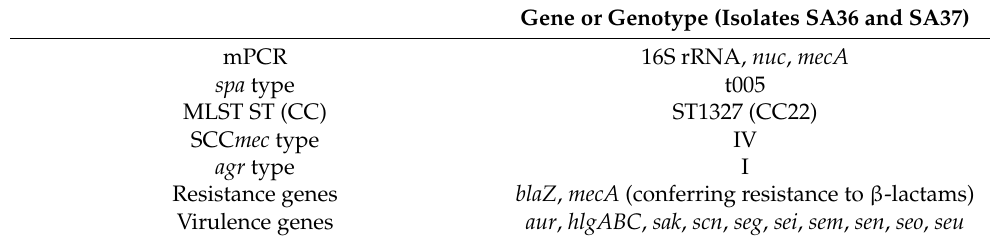
Table 2. Genetic characteristics of the hemolytic MRSA isolate SA37 and the nonhemolytic MRSA isolate SA36. Note that only the genes that are present are reported.